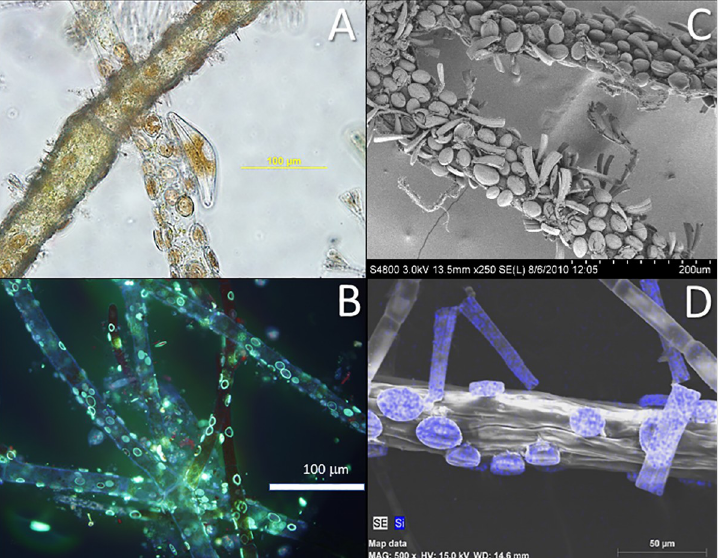
Fig 3. A . Light microscopy image of Cladophora filament with encrusting diatom epiphytes. B . Epifluorescence microscopy image of PDMPO-labeling of bSi (pale green) accumulation in epiphytic diatoms on surfaces